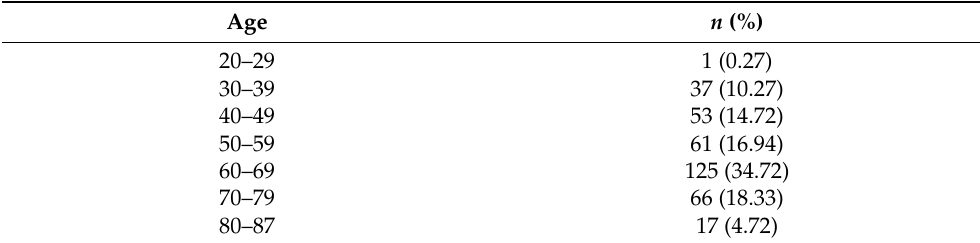
Table 1. Age distribution of 360 women who were diagnosed with pelvic organ prolapse.